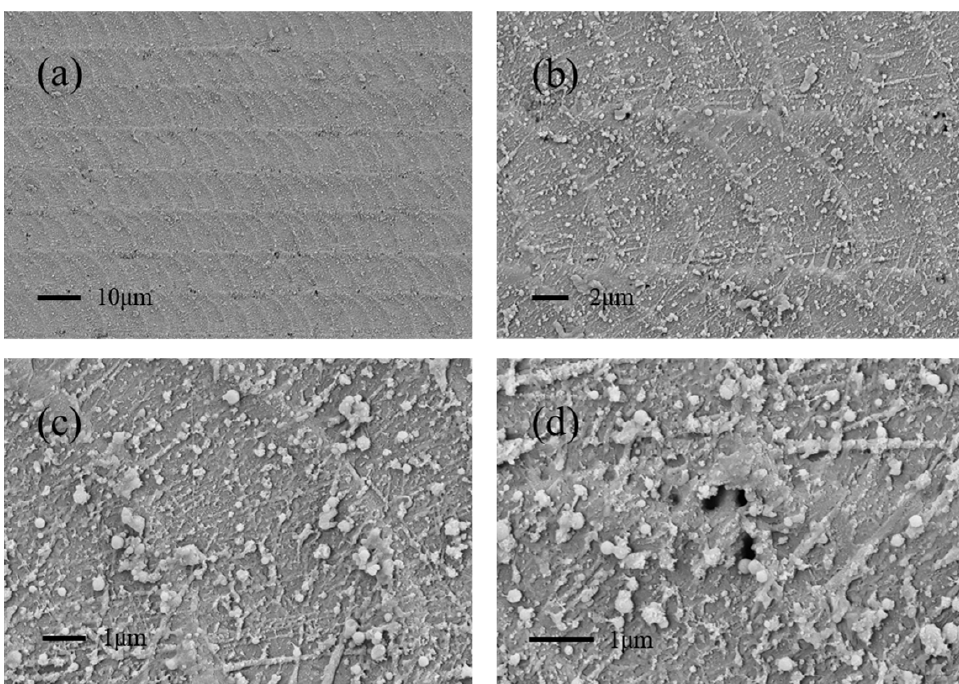
Figure 6. SEM image of the laser-textured glass with different magnifications when the infrared laser scanning distance is 5 μ m. ( a ) 1000 times magnification, ( b ) 4000 times magnification, ( c ) 10,000 times magnification, and ( d ) 15,000 times magnification.